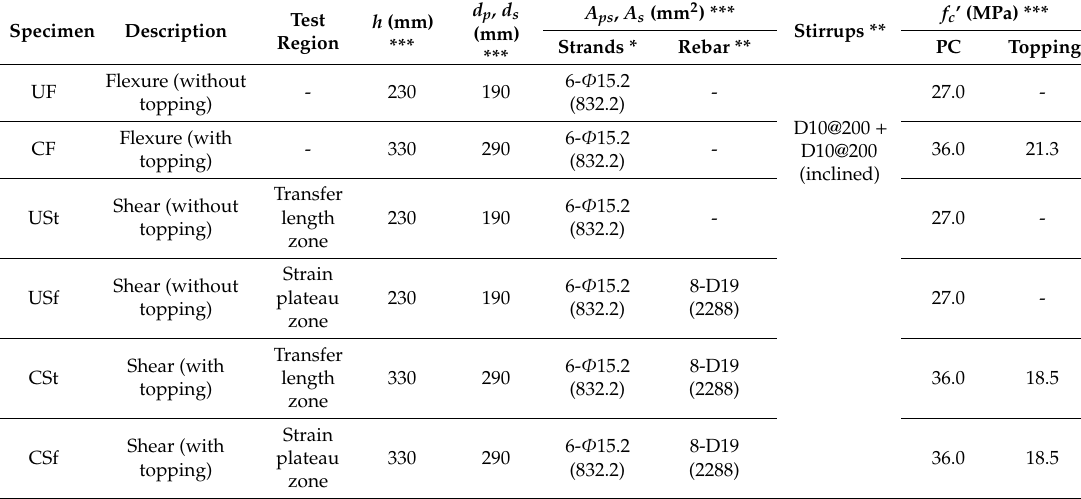
Table 1. Details of the test